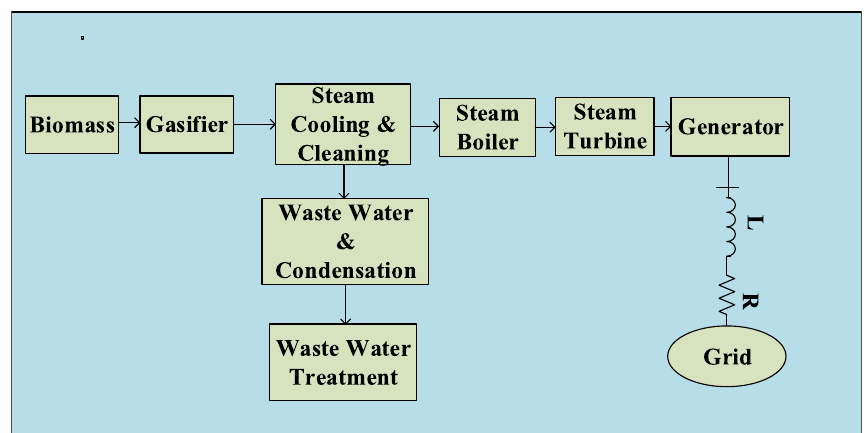
Fig. 10 Bio-Energy Generation